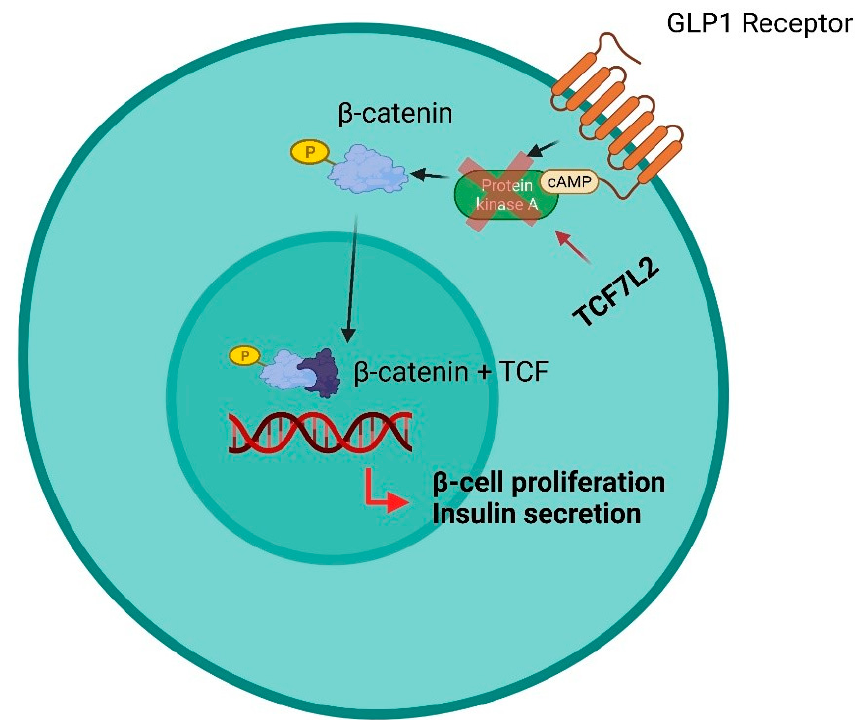
Figure 1. Influence of SNPs in the TCF7L2 gene in response to treatment with SU derivatives, GLP1-RA and DPP-4 inhibitors. In the pancreatic β -cell, GLP-1 phosphorylates β -catenin via cAMP-dependent protein kinase A (PKA). This avoids the degradation of the β -catenin that subsequently accumulates, enters the nucleus and forms the transcription factors β -catenin/TCF. This leads to activation of genes such as Isl-1 and Axin2. Overall, this pathway results in pro-insulin processing, β -cell protection from IL-1 β and interferon- γ -mediated apoptosis, stimulation of β -cell proliferation and glucose/GLP-1-stimulated insulin secretion. Patients with TCF7L2 gene variants have impaired TCF7L2 expression in pancreatic β -cells resulting in reduced insulin secretion and impaired response to incretins (GLP1-RA, DDP-4 inhibitors). The abnormal response to GLP1-RA and DPP-4 inhibitors is likely to depend on the direct effect of TCF7L2 on PKA.